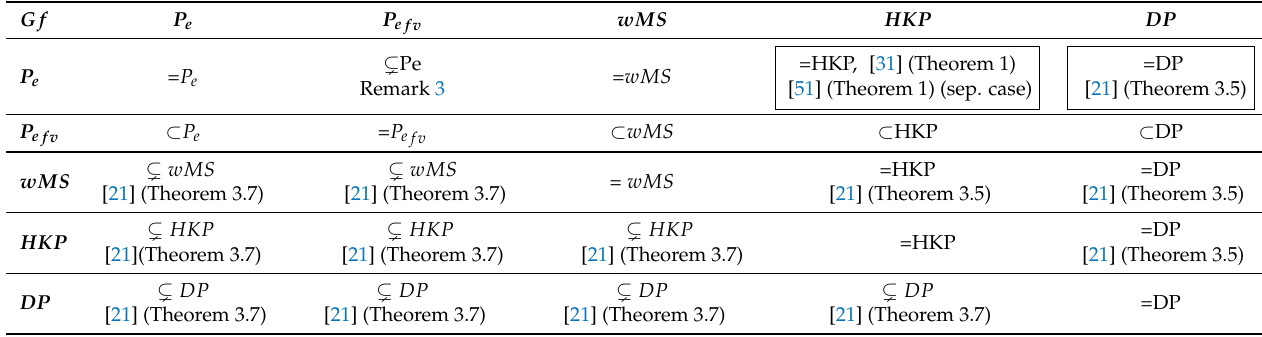
Table 3. Γ = G + f . G and f scalarly